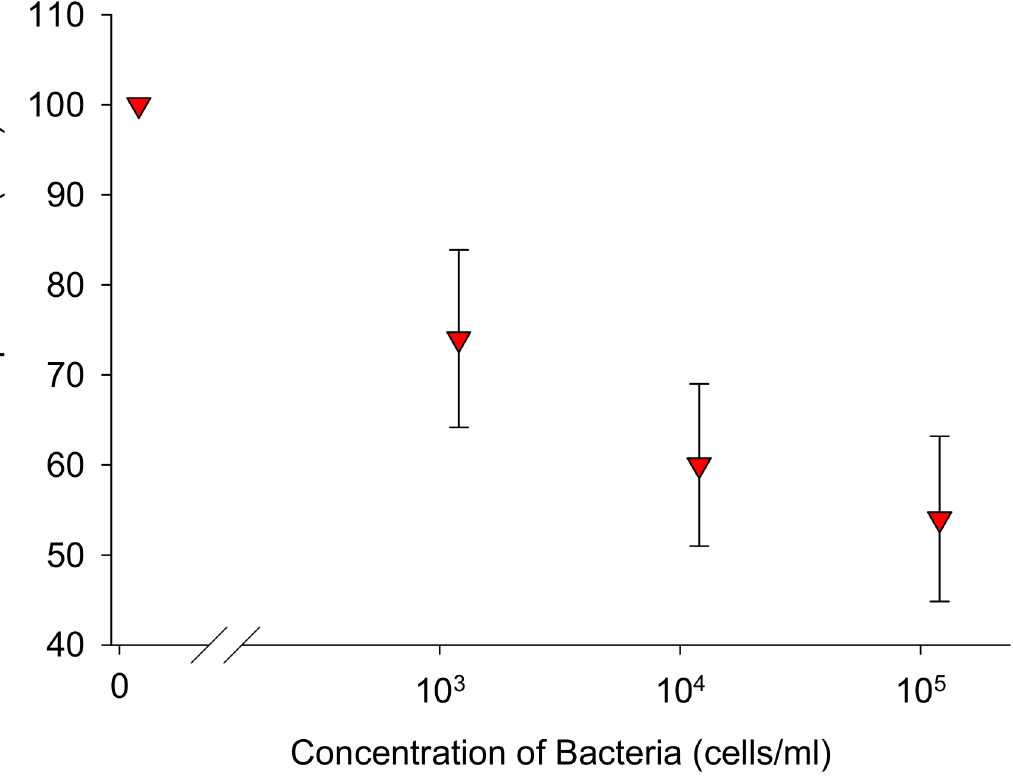
Fig 4. Time to amplification of TB DNA eluted directly into LAMP reaction solution. DNA was extracted from lysed surrogate sputum samples using the manual extraction technique and eluted into LAMP reaction solution. All three concentrations of surrogate sputum amplified in the extraction tubing. One negative control sample amplified in the 100 minute assay time. N =